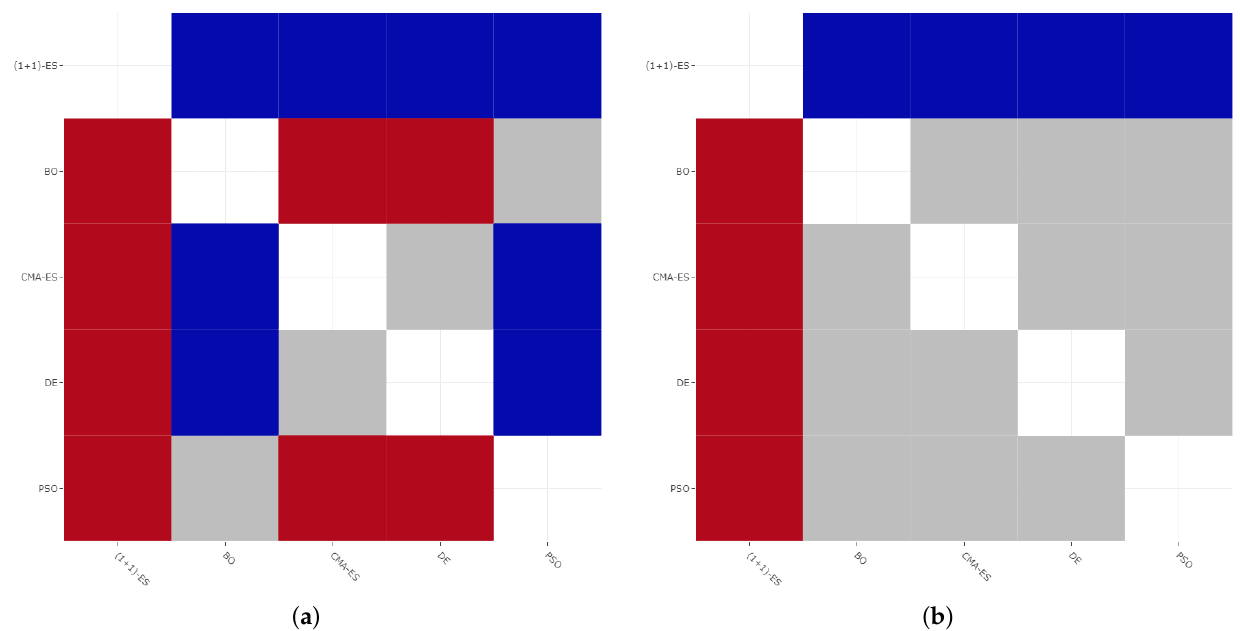
Figure 7. Results of the Kolmogorov-Smirnov tests with significance level 0.01. A red entry means that column-algorithm is significantly better than row-algorithm; a blue entry means that row-algorithm is significantly better than column-algorithm; a grey entry means that there is no statistical difference between the algorithms. ( a ) Case study 1—River Paglia; ( b ) Case study 2—River